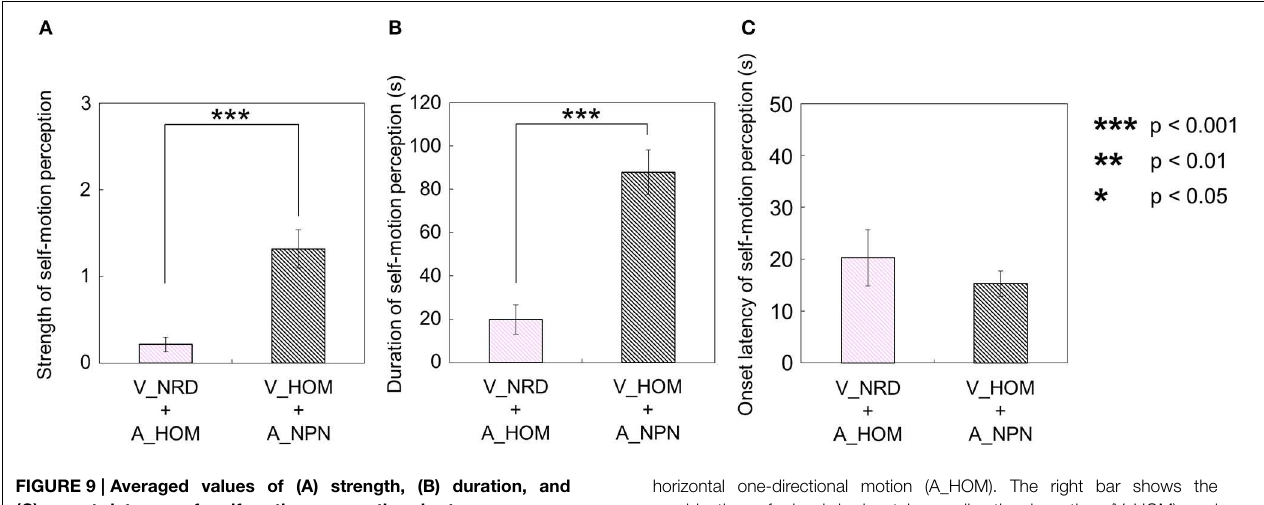
horizontal one-directional motion (A_HOM). The right bar shows the combination of visual horizontal one-directional motion (V_HOM) and no auditory stimulus (A_NPN). The error bars represent standard error